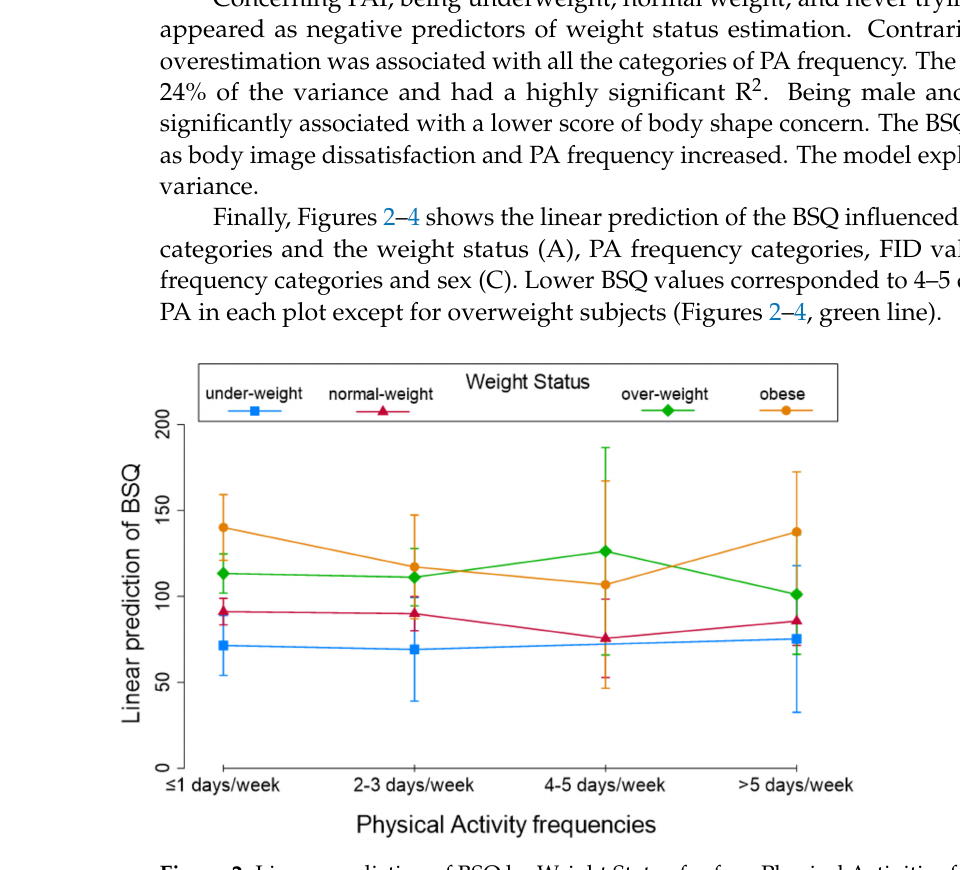
Figure 2. Linear prediction of BSQ by Weight Status for four Physical Activities